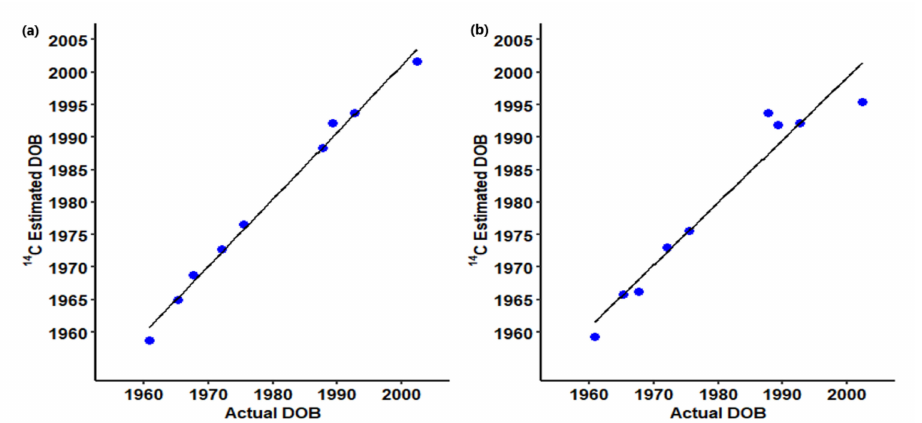
Figure 2. Linear regression analysis of ( a ) the estimated date of birth (dob) based on 14 C analysis of tooth crown and actual dob (R 2 = 0.991). ( b ) the estimated dob based on 14 C analysis of tooth roots and actual dob (R 2 =